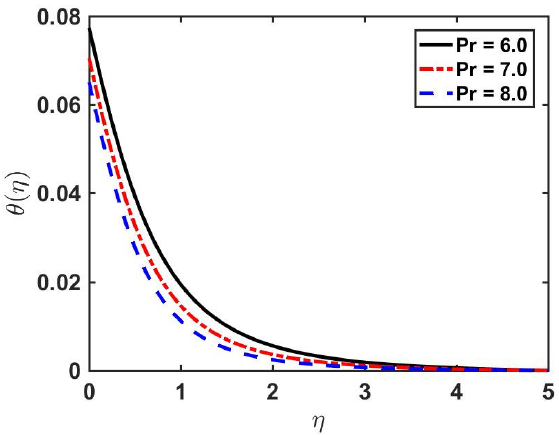
Figure 5. Effect of 𝑷𝒓 on 𝜽(𝜼) .